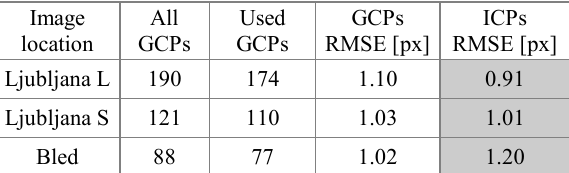
Table 2: RMSE values for three WorldView-2 level 1B images processed with the RPC model.